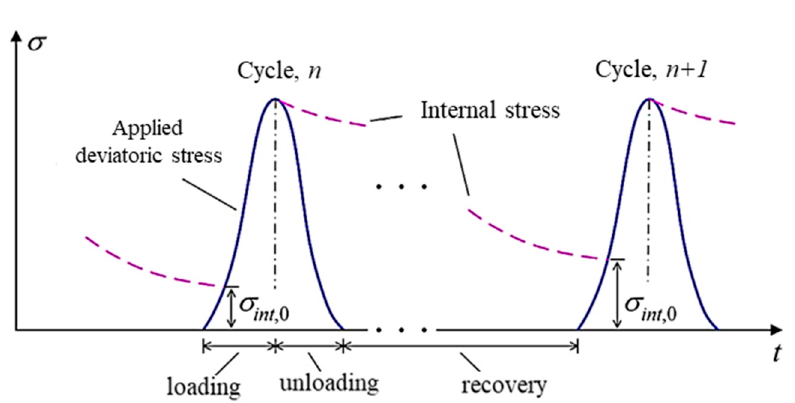
Figure 8. Schematic of representation of internal stress evolution during loading and unloading. Adapted with permission from [ 53 ] . 2016, Mechanics of Materials, Elsevier.